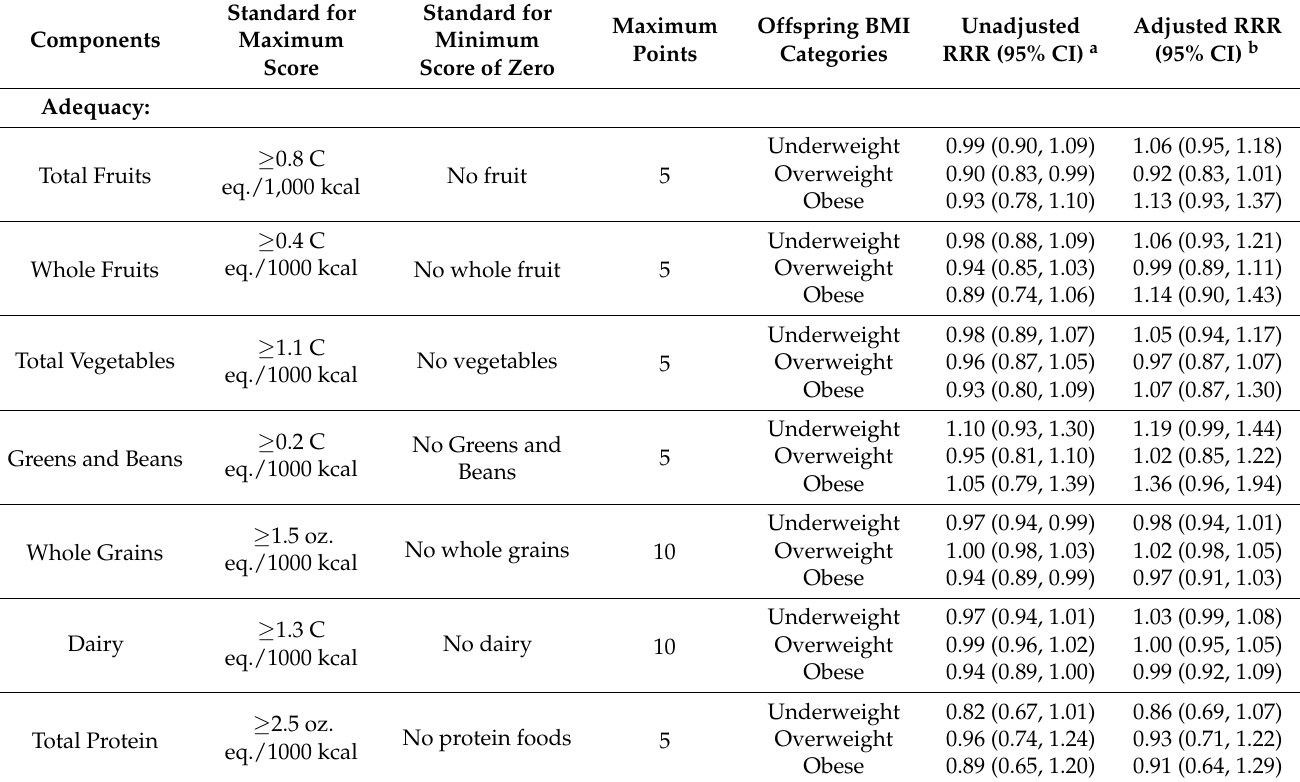
Table 4. Relationship between each dietary component of HEI-2015 scores and childhood BMI categories ( n = 3391).